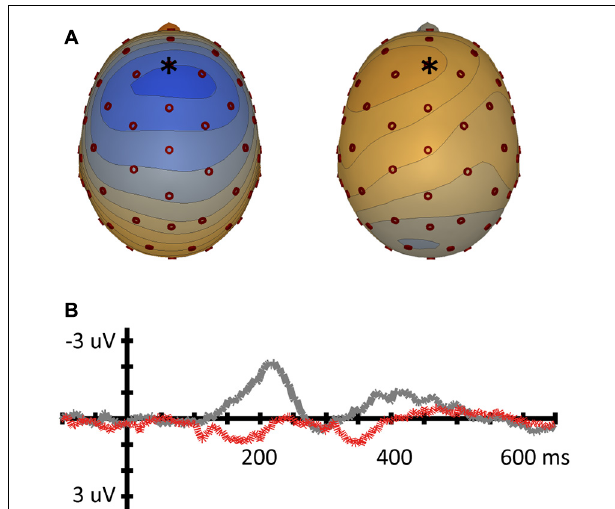
FIGURE 4 | Mismatch negativity for the place contrast (vowel pair /o-ø/). (A) Topographic voltage plots of the MMN at the average MMN peak latency for both conditions (left: [ø]/o/, 210 ms; right [o]/ø/, 239 ms). Blue in topoplot indicates negative potential ( µ V), red positive potential, electrode Fz is indicated with an asterisk. (B) MMN waveforms for the Fz electrode [ø]/o/ (gray) and [o]/ø/ (red dashed).